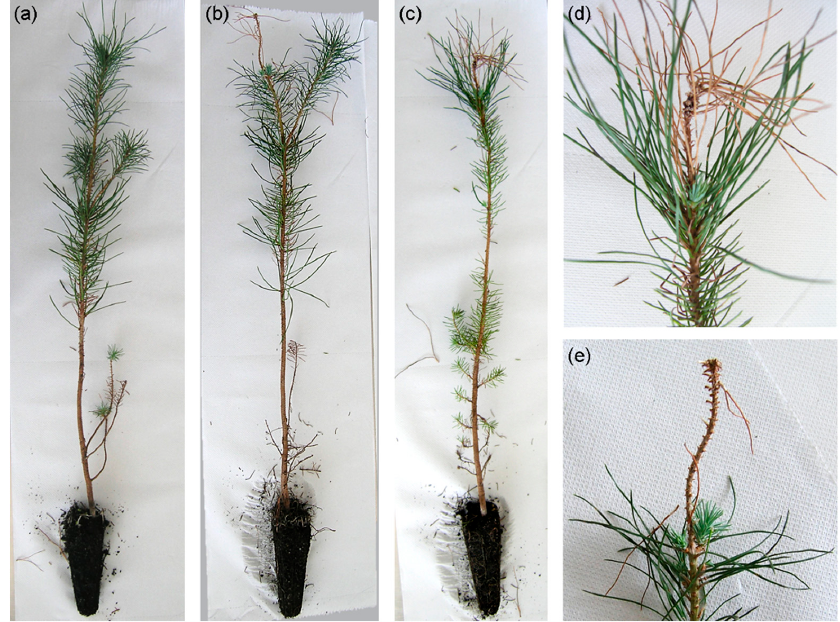
Figure 3. Aspect of inoculated seedlings four months after the inoculations. ( a ) Asymptomatic plant. ( b , c ) Symptomatic plants inoculated with Pestalotiopsis pini sp. nov. ( d , e ) Detail of dead apical shoots on symptomatic plants.